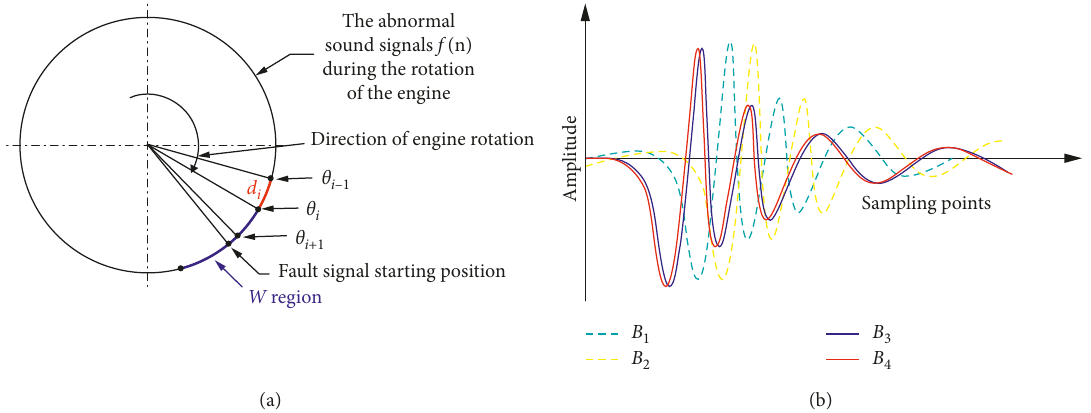
Figure 4: Relationship between fault features acquired at different phases. (a) Intercepting abnormal signals at different phases. (b) Intercepted results at θ i and θ i+ 1 , where f ( n ) is the abnormal sound signal generated during engine operation, d i denotes the length of the abnormal signal between phases θ i and θ i+ 1 , B 1 represents the fault component intercepted at θ i , B 2 refers to the fault component intercepted at the next θ i , B 3 indicates the fault component intercepted at θ i+ 1 , and B 4 signifies the fault component intercepted at the next θ i+ 1 . In comparison with θ i+ 1 , θ i is far from the position where the fault component exists, and a large positional deviation may occur between B 1 and B 2 acquired at θ i in different q revolutions due to slight changes in the engine speed. θ i+ 1 is close to the position where the fault component exists. If the deviation between B 3 and B 4 is small enough and can be regarded as a natural error, then the starting point can be selected at the position of θ i+ 1 .